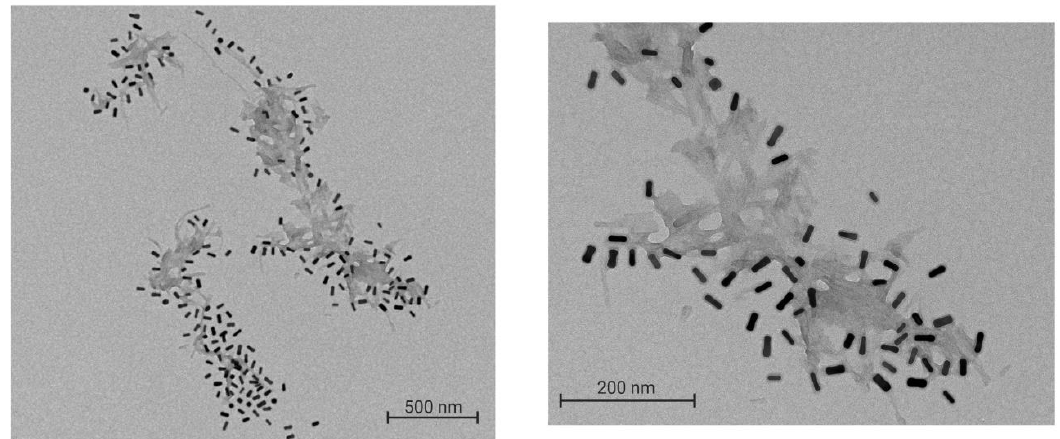
Figure 8. TEM image of GNR-PEG-D1 decorating the Aβ fibrils. A total of 0.5 nM GNR-PEG-D1 was incubated with a 10 μM Aβ solution for 20 min at 37 °C, with mechanic agitation. Left image: magnification x 10,000; right image: magnification x 30,000.